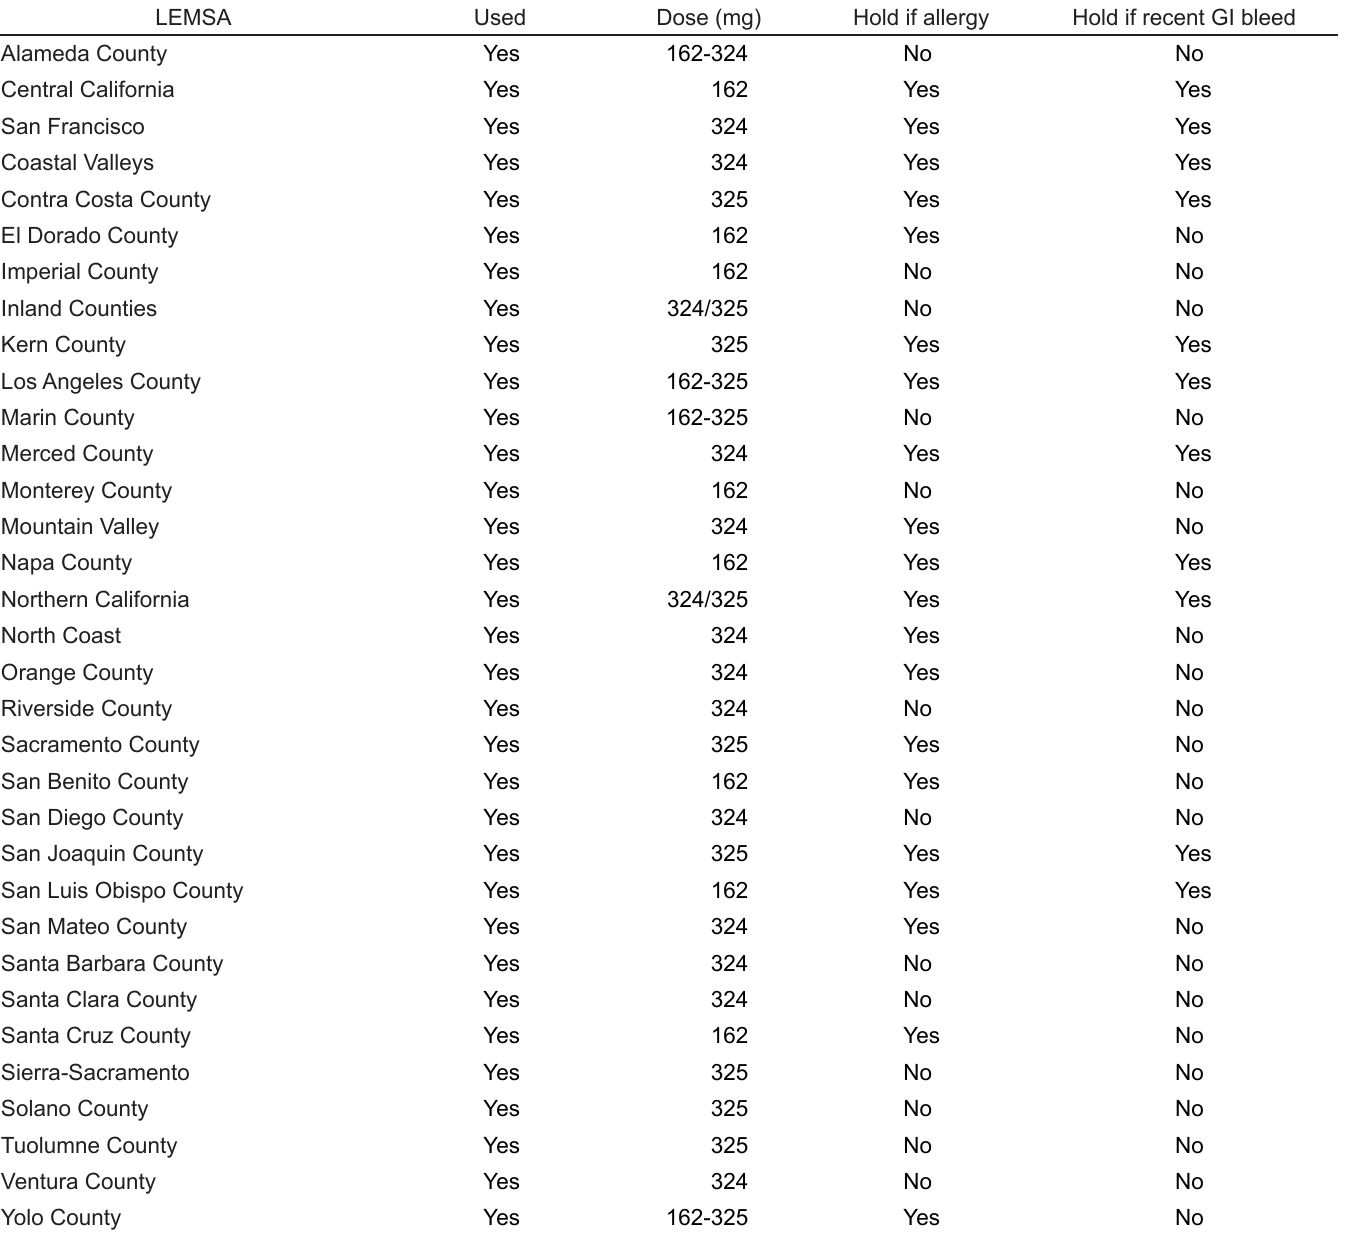
Table 2. Aspirin use in patients with chest